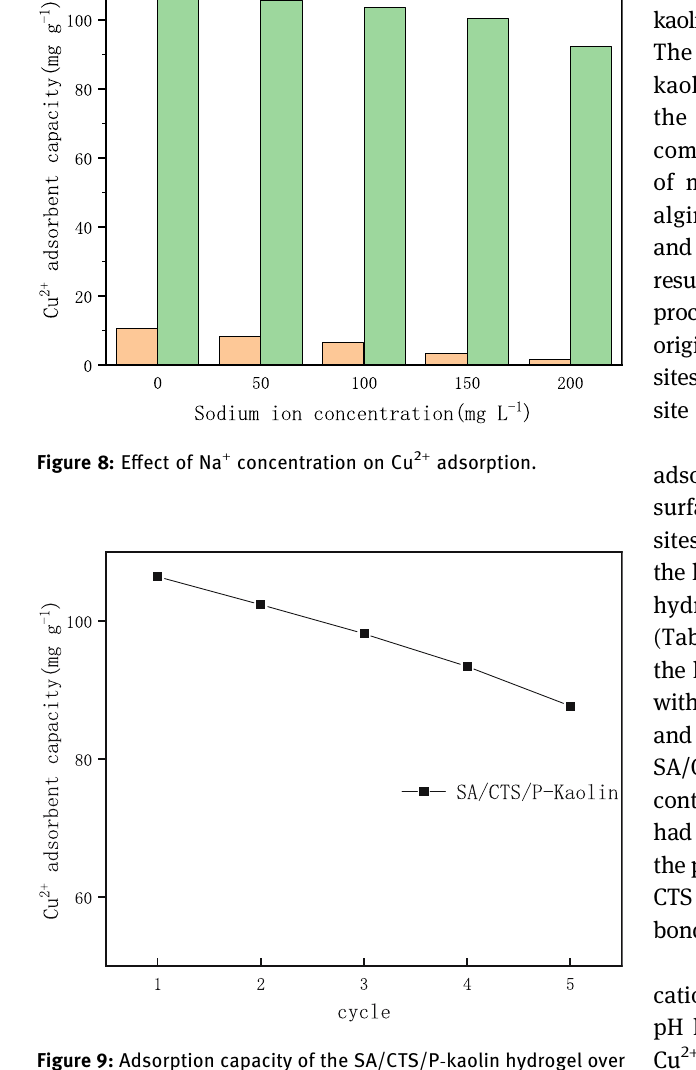
Figure 9: Adsorption capacity of the SA/CTS/P - kaolin hydrogel over fi ve adsorption – desorption